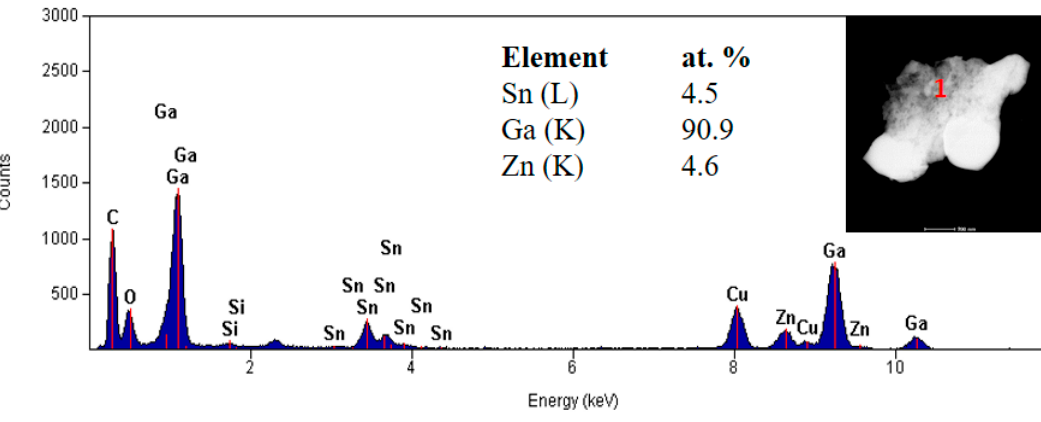
Figure 6. EDS point analysis of the chemical composition of the material. Insert: dark field image.